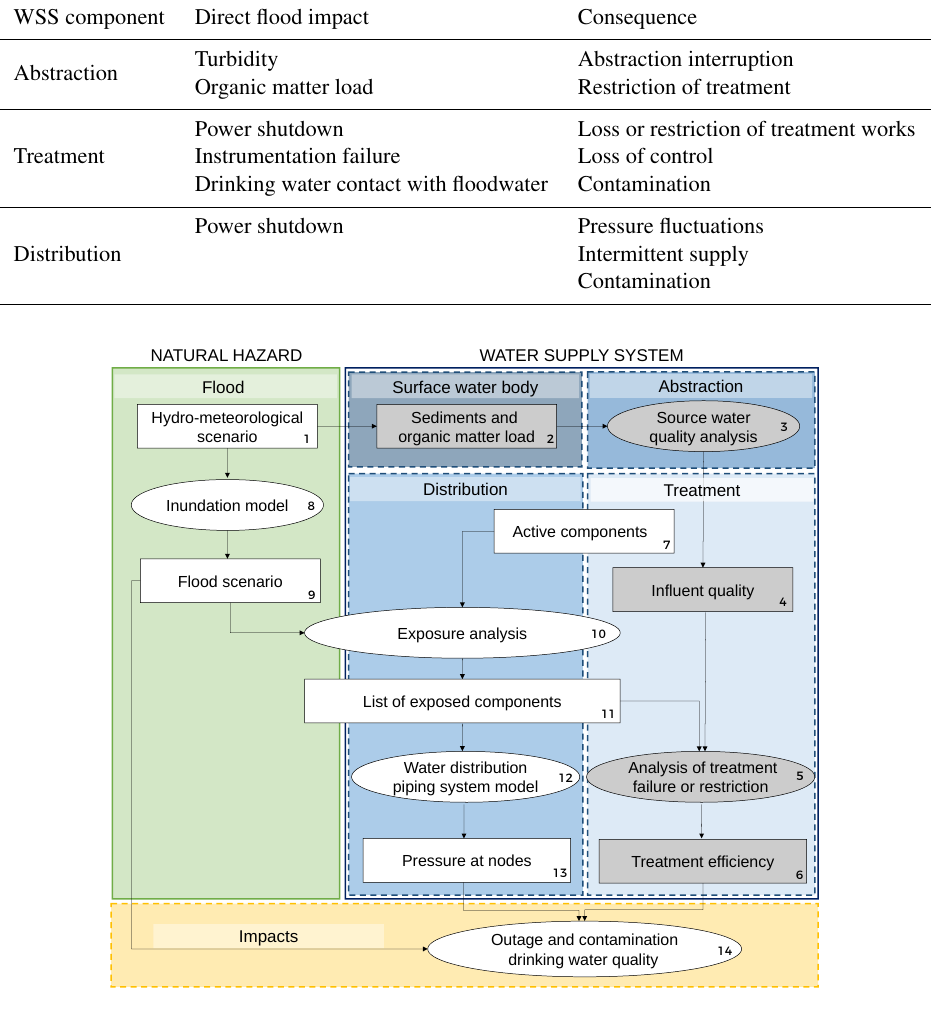
Figure 1. Flood risk assessment scheme for WSS (ellipses stand for activities and rectangles represent data flow; shaded boxes represent activities that are not carried out in this